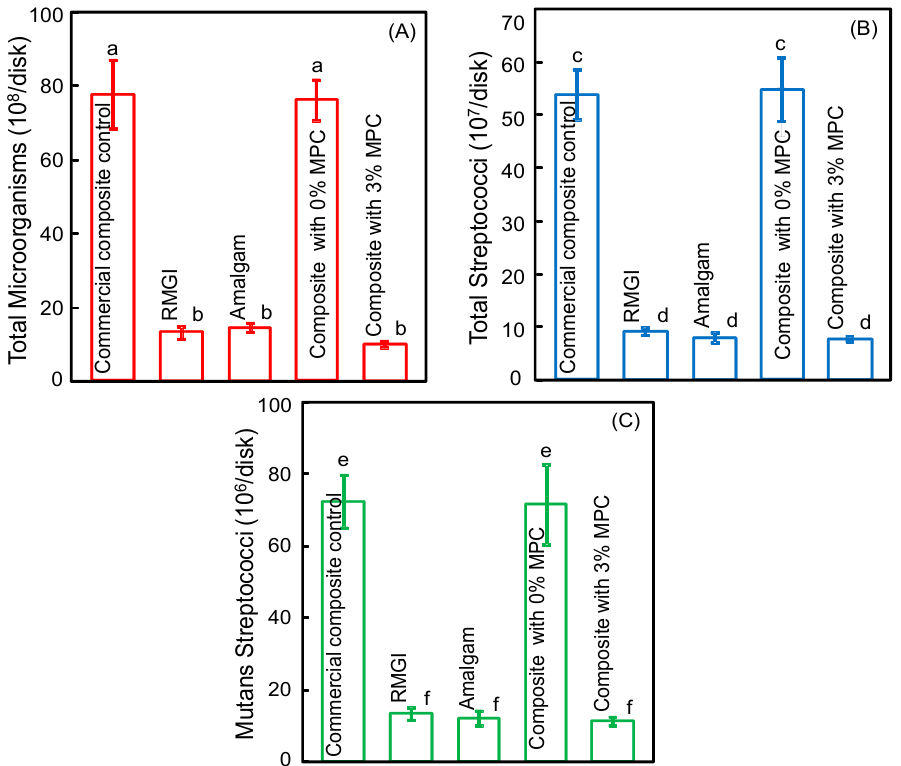
Figure 4. Colony-forming unit (CFU) counts of two-day biofilms on disks (mean ± sd; n = 6). ( A ) Total microorganism CFU; ( B ) total streptococci CFU; and ( C ) mutans streptococci CFU. In each plot, values with dissimilar letters are significantly different from each other ( p < 0.05). The mechanical properties are plotted in Figure 5: (A) Flexural strength; and (B) elastic modulus (mean ± sd; n = 6). The strength of the protein-repellent composite with 3% MPC matched those of the composite control with 0% MPC and the commercial composite control ( p > 0.1). They all exceeded 3% MPC also matched those of the commercial composite and the control composite with 0% MPC ( p > 0.1).